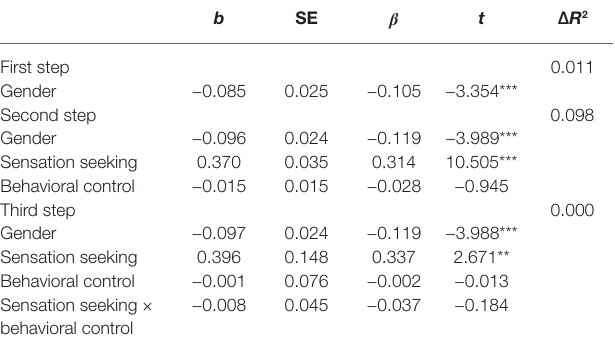
TABLE 4 | The relationship between sensation seeking and the use of tobacco and alcohol: the regulation of behavioral